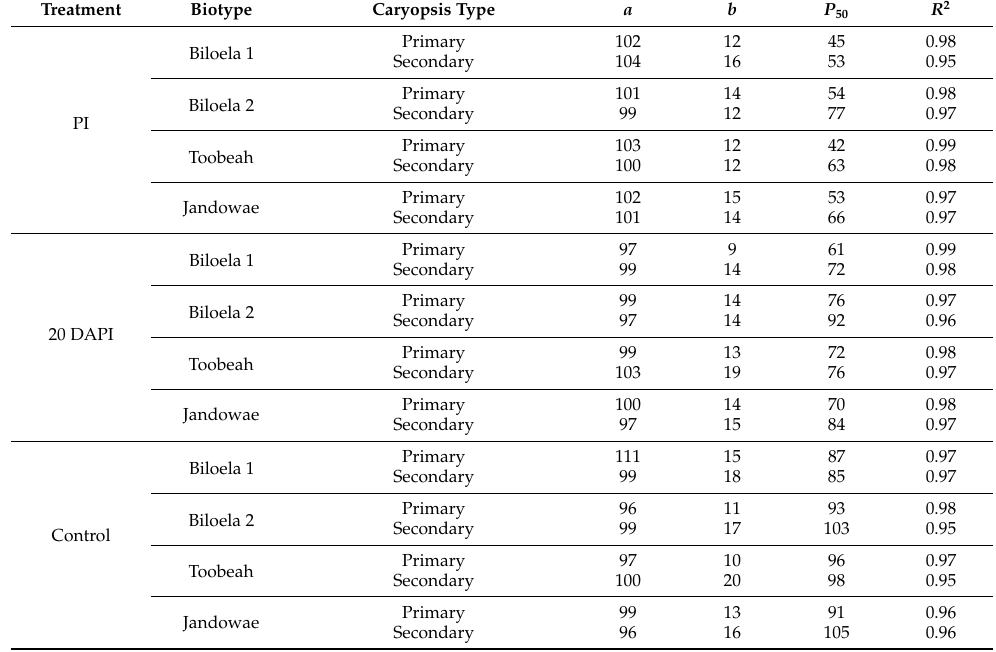
Figure 8. Response of ( A ) primary caryopses, and ( B ) secondary caryopses from four Avena sterilis ssp. ludoviciana biotypes to controlled aging at 48 ◦ C and 60% relative humidity. Caryopses used in the test were either produced under elevated temperature applied at panicle initiation (PI) or 20 days after panicle initiation (20 DAPI) along with a control (no imposition of elevated temperature) treatment. Viability is expressed as the percentage of normal germination during 21 days of incubation at 15/5 ◦ C day/night temperature with a matching 12/12 h light/dark photoperiod. The horizontal dashed line running across each panel identifies the time for a 50% reduction in viability of the seeds produced under different treatments. Table 2. Fitted initial viability percentage ( a ), rate of viability loss in the rapidly declining section of the curve ( b ), days taken to 50% viability loss ( P 50 ) and coefficient of determination ( R 2 ) of primary and secondary caryopses of four biotypes of Avena sterilis ssp. ludoviciana found in the controlled aging test (CAT) at 48 ◦ C and 60% RH. Caryopses used were produced under elevated temperature applied at panicle initiation (PI) and 20 days after panicle initiation (20 DAPI) along with a control (no imposition of elevated